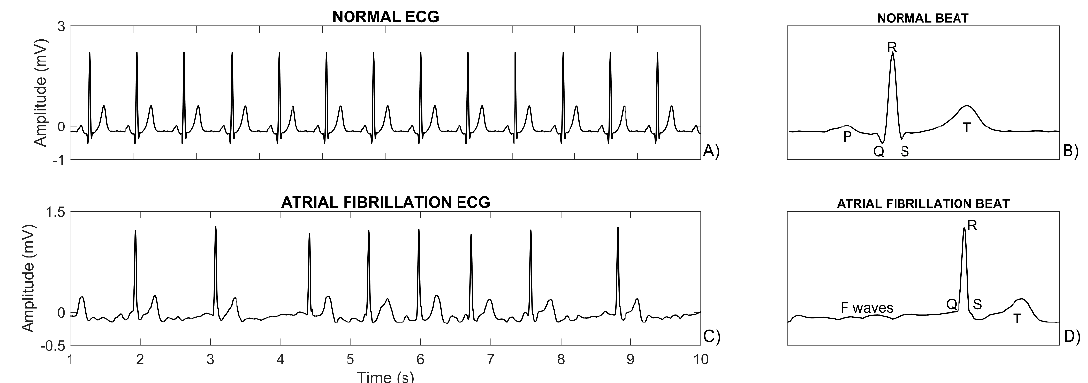
Figure 1. Panel A shows a normal pseudo-periodic electrocardiogram (ECG) tracing. Panel B shows a normal beat, constituted by a P wave (the smallest wave), a QRS complex (with R being the highest wave) and a T wave. Panel C shows an ECG tracing with atrial fibrillation (AF) and thus increased heart rate variability (HRV). Panel D shows a beat during AF with F waves but no P wave.